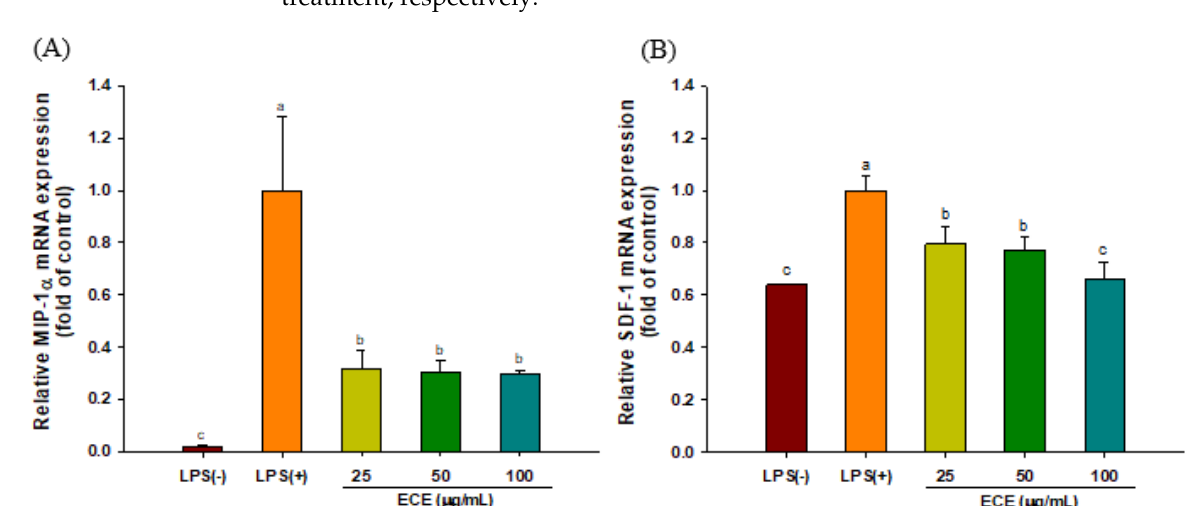
Figure 2. Effect of ECE on LPS-stimulated inflammatory chemokines ( A ) MIP-1α and ( B ) SDF-1 mRNA expressions in HGF-1 cells. Different letters (a–c) show significant difference ( p < 0.05). ECE: Ecklonia cava extract; MIP-1α: macrophage inflammatory protein 1-alpha, SDF-1: stromal cell-derived factor 1. LPS: lipopolysaccharide; HGF: human gingival fibro- blasts.